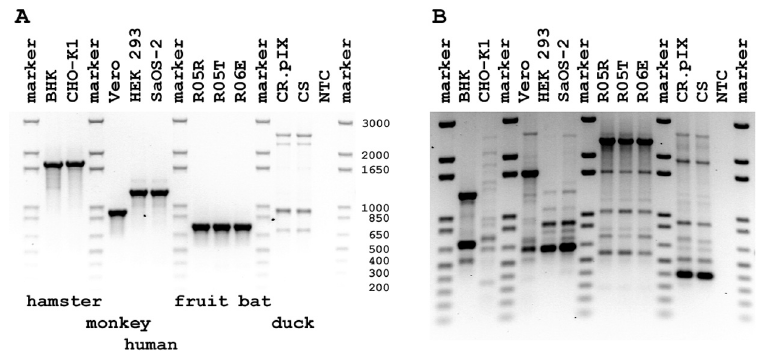
Figure 1. Species-specific PCRs. ( A ) Genomic DNA was isolated from different cell lines and analyzed by PCR using a primer pair designed to amplify across an intron of the conserved MACF1 gene; ( B ) Isolated genomic DNA was analyzed by a single-primer PCR to amplify minisatellites. Abbreviations for cell lines: BHK, Syrian baby hamster kidney; CHO-K1, Chinese hamster ovary; HEK 293, human embryonic kidney; SaOS-2, human osteosarcoma; R05R, R05T, R06E, Rousettus aegyptiacus ; CR.pIX, CS, Cairina moschata retina or somites; Vero, African green monkey. NTC for non template control.